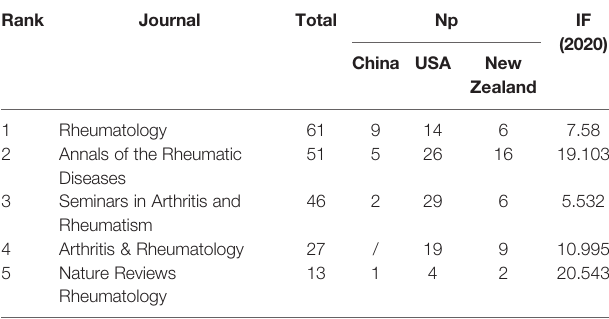
TABLE 6 | Correlation of high-quality journals with high attention and the most productive